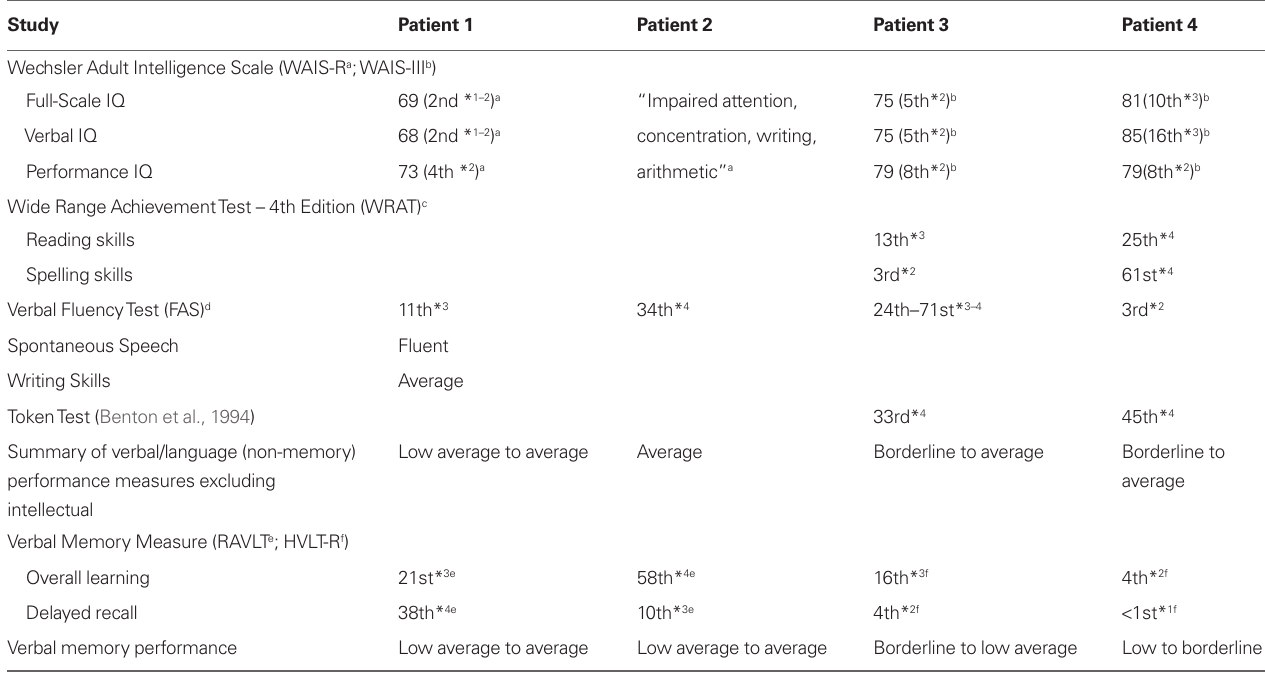
Table 1 | Pre-operative neuropsychological assessment in English (L2) for all